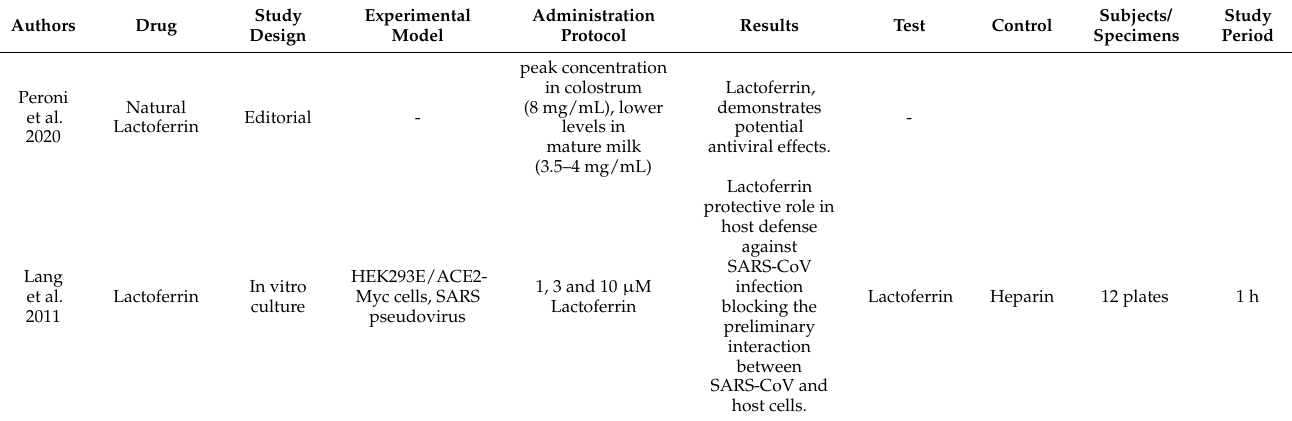
Table 3. Summary of COVID-19 lactoferrin adjuvant